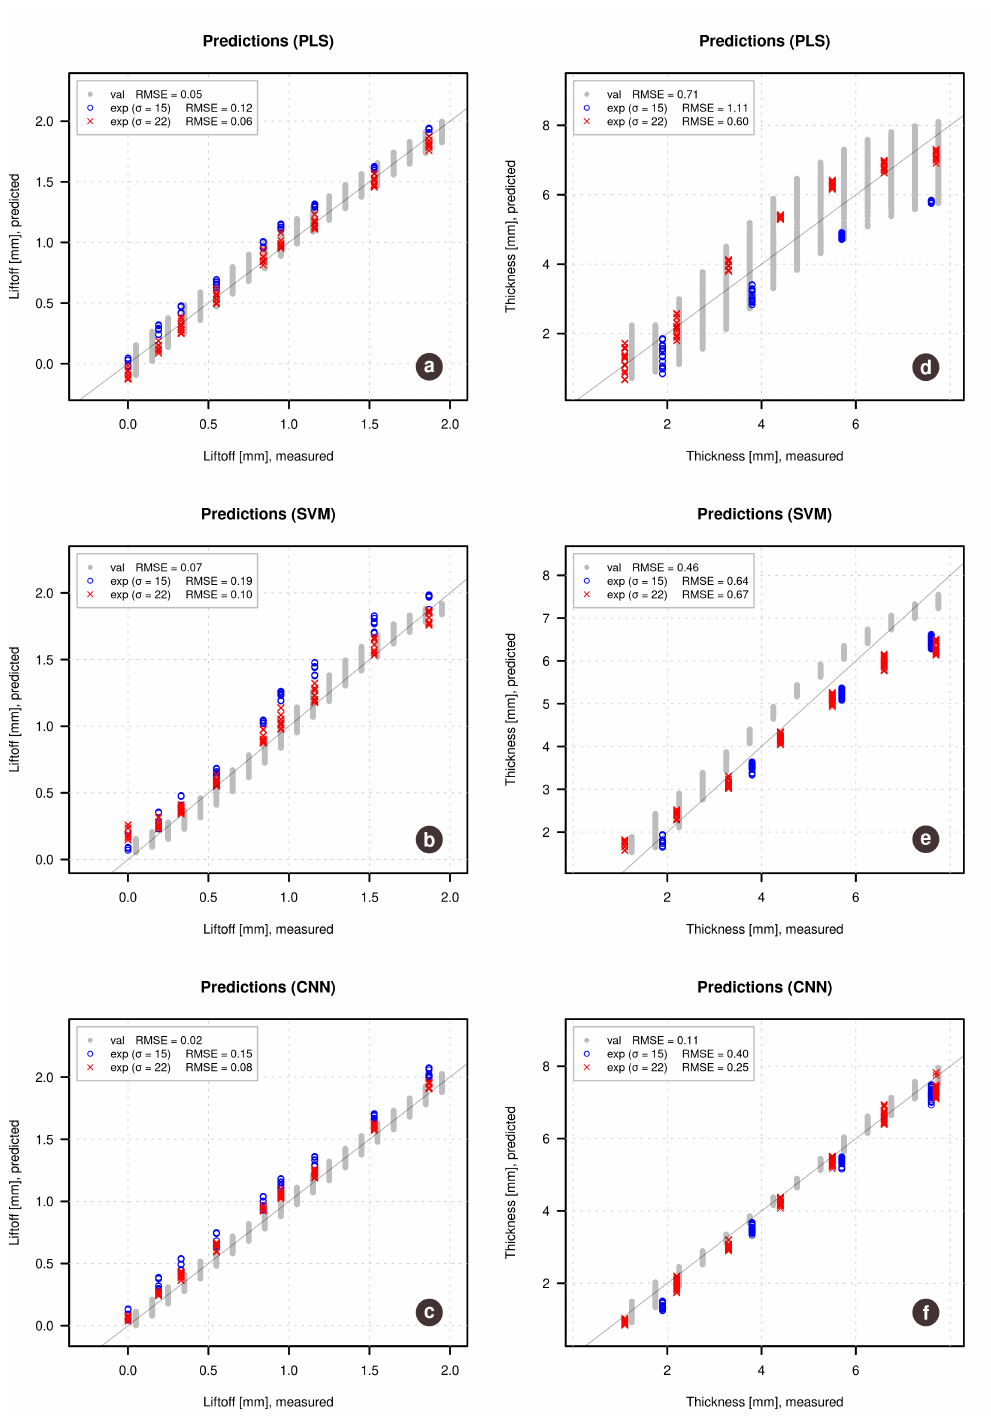
Figure 5. Predicted vs. measured plots for lift-off ( left ) and sample thickness ( right ) similar to what is shown in Figure 4 but for models optimized using the experimental data (a,d—PLS; b,e—SVM;